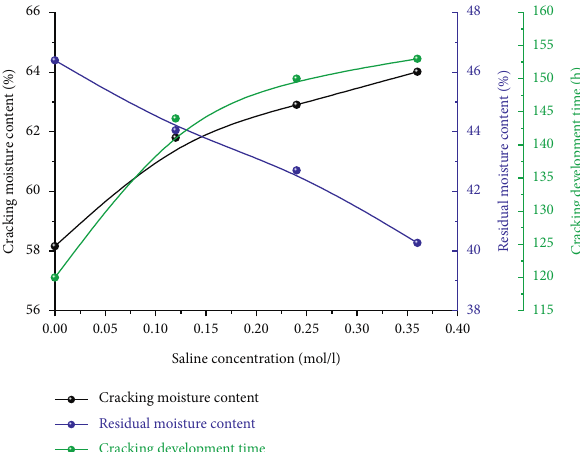
Figure 6: Cracking moisture content, residual moisture content, and cracking duration varying with saline